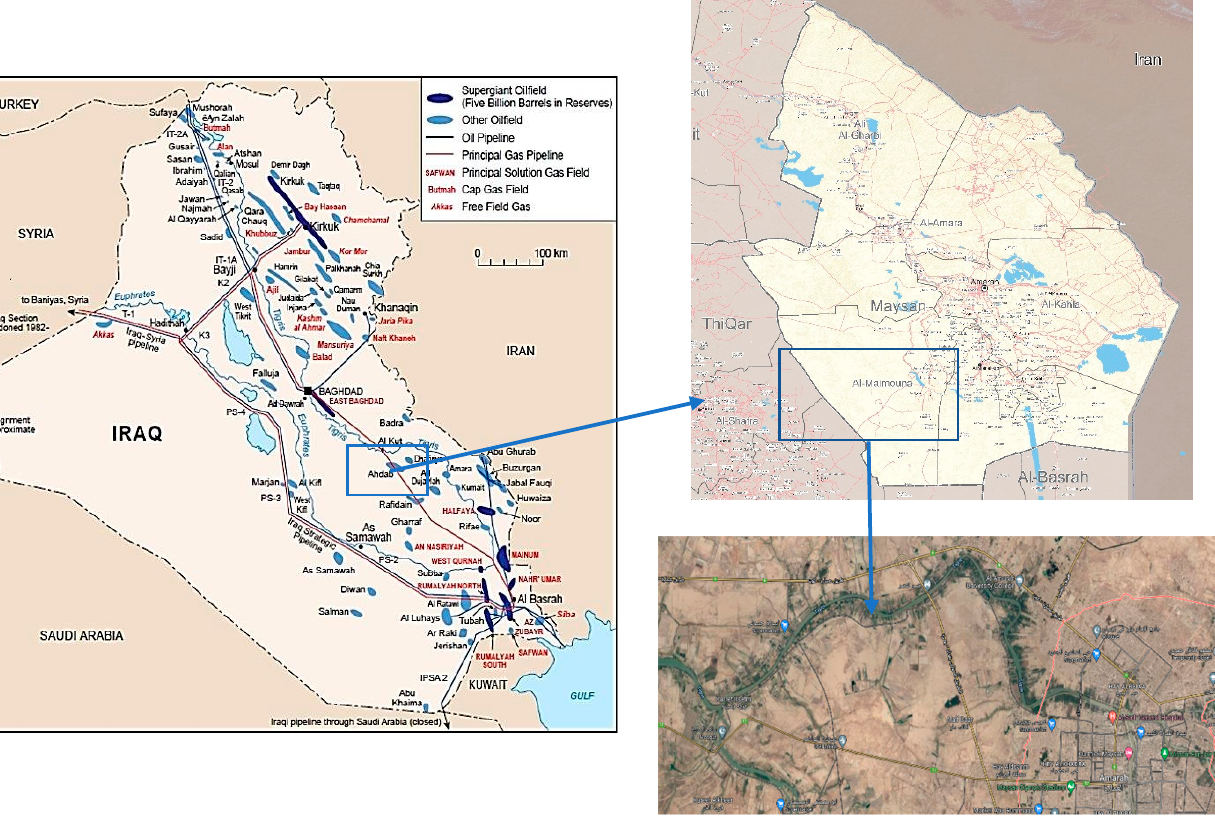
Figure 1. Study area, Amarah City, Iraq.